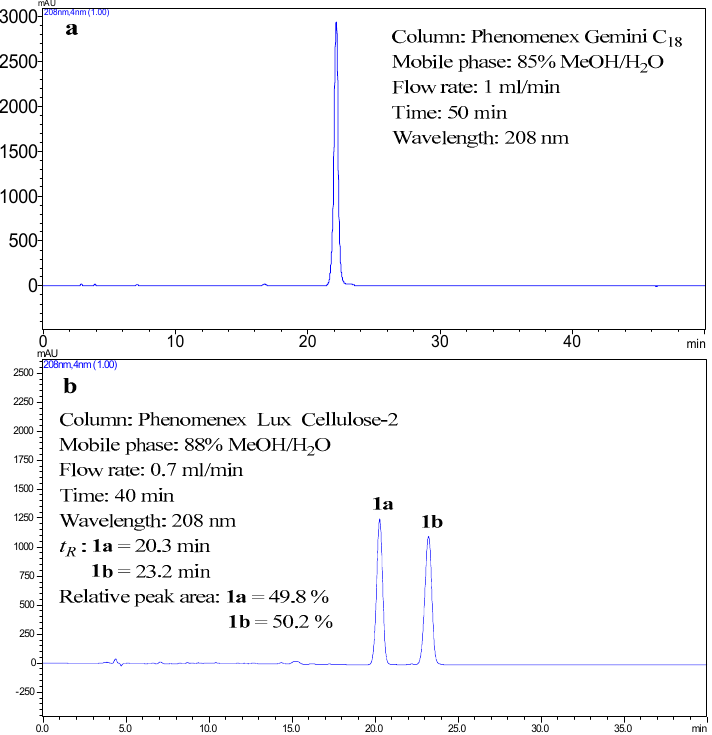
Figure 3. HPLC analysis of 1 . a : the analysis of 1 on routine ODS HPLC; b : the analysis of 1 on chiral HPLC.